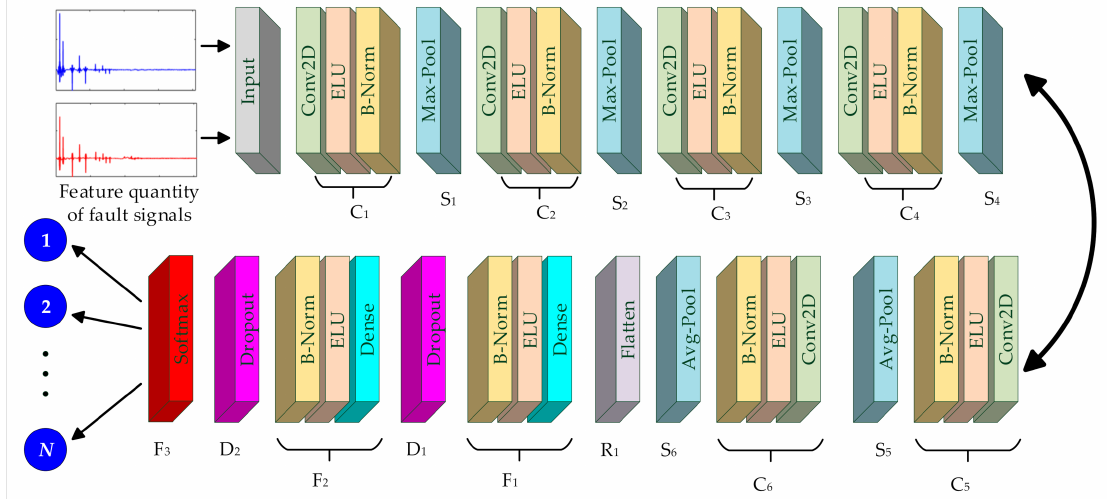
Figure 4. Deep 2D-CNN structural diagram for fault segment